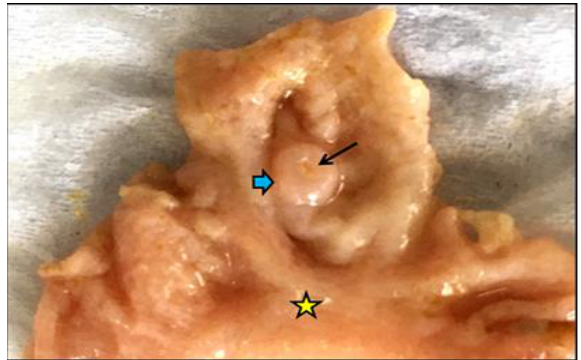
Figure 10. Internal view of the 1st duodenal flexure (yellow star) showed duodenal papilla (blue arrow) with its central opening (black arrow) of the common bile